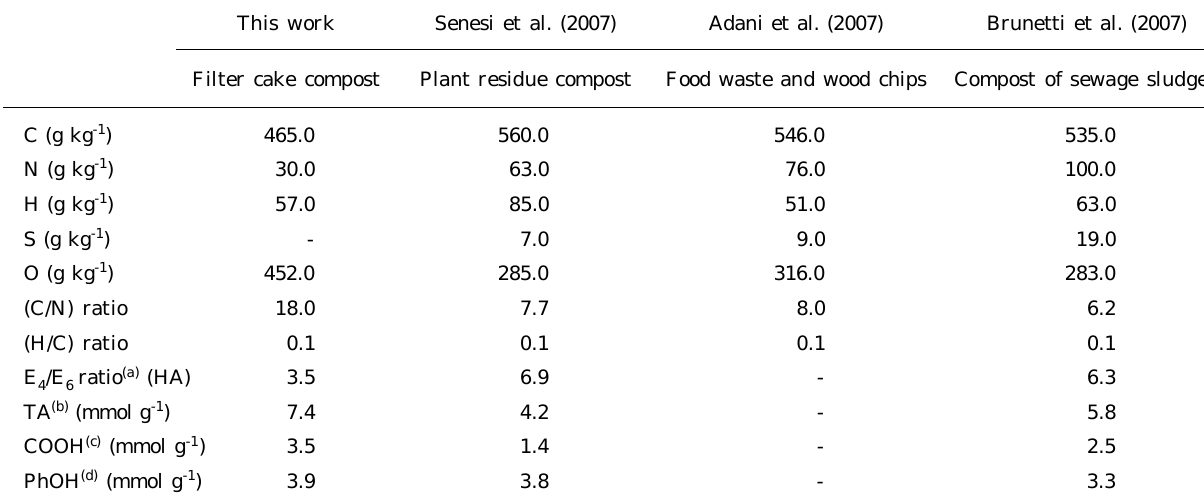
Table 2. Elemental composition, C/N, E 4 /E 6 ratio and acidic functional group content of humic acids extracted from different composts